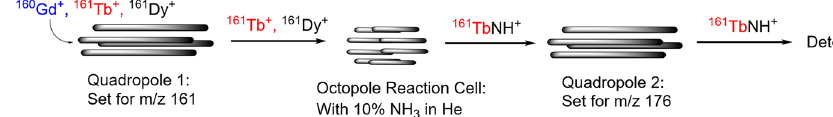
Fig. 5 Resolution of 161 Tb and 161 Dy ions via NH 3 Mass Shift mode with